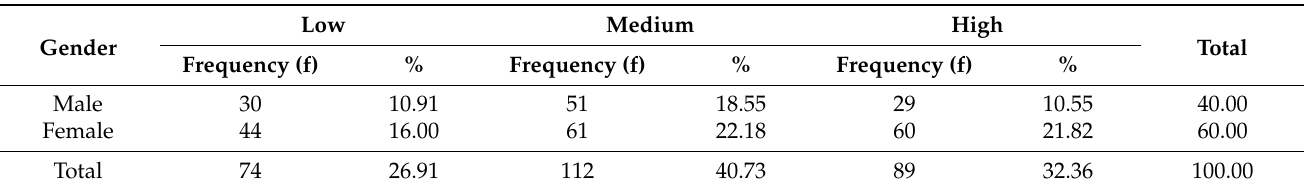
Table 5. Level of the remote work variable in Peruvian workers during the COVID-19 pandemic, according to